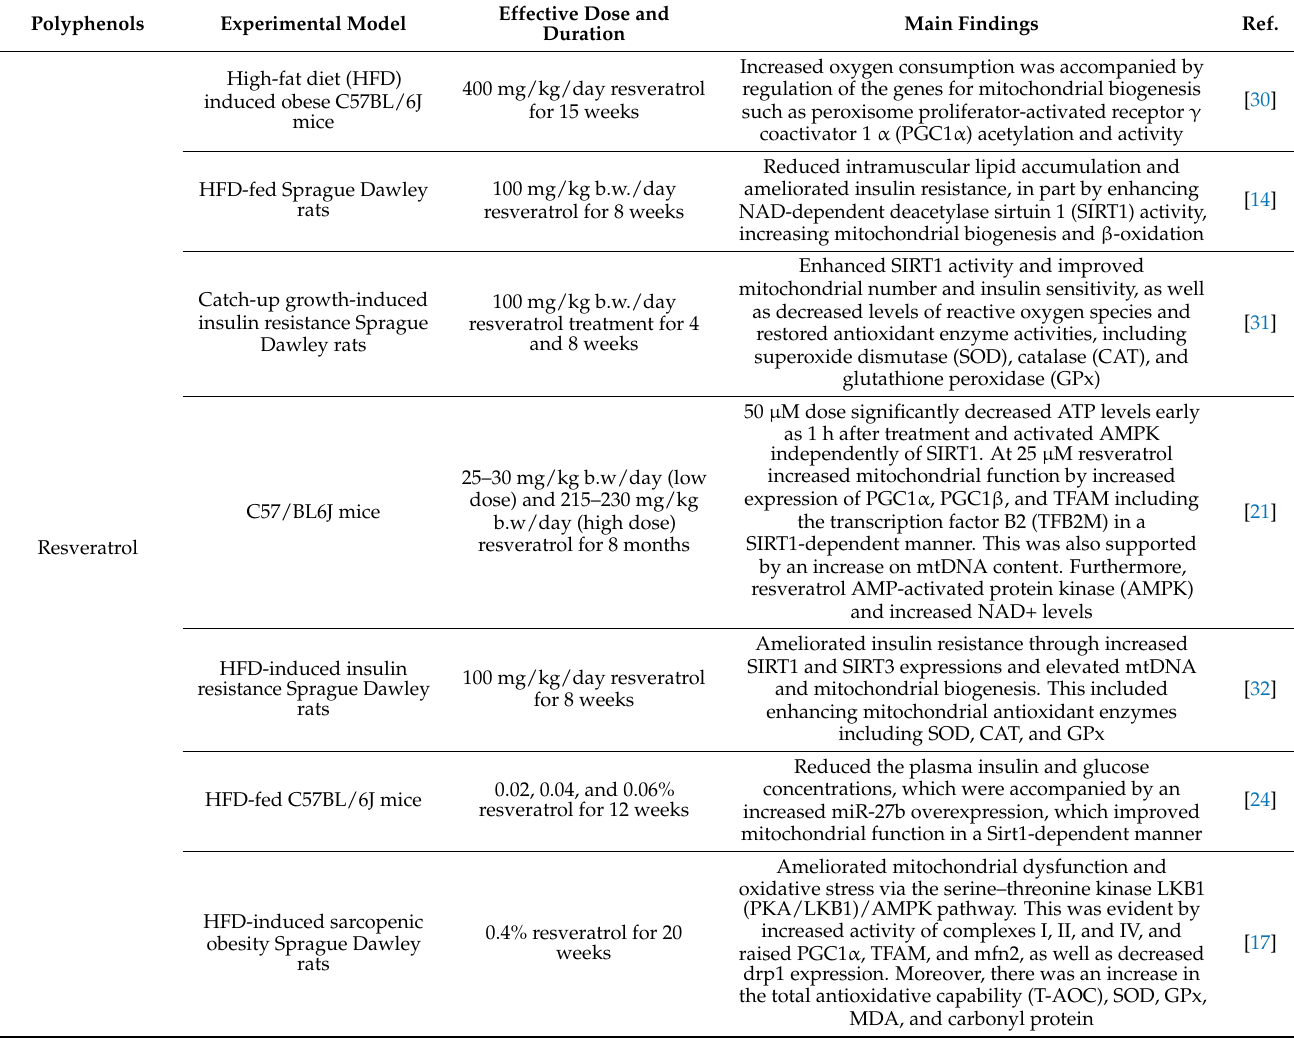
Table 2. A summary of in vivo studies reporting on the impact of polyphenols on mitochondrial bioenergetics and metabolic function within the skeletal